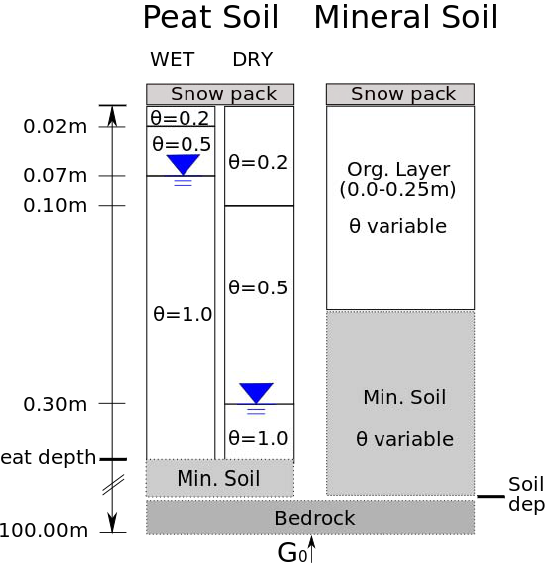
Fig. 1. Conceptual overview of the water level and water content ( θ ) in peatland for the wet (water table at 0.07m ) and dry scenario (water table at 0.30m) and the organic layer in mineral soils. G 0 is the geothermal heat flux. Mineral soil layer depth, snowpack depth, and bedrock depth are not drawn to